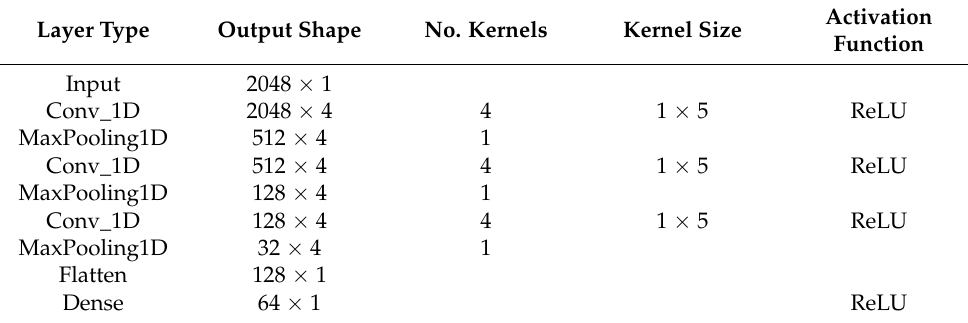
Table 3. The parameters of the proposed Siamese network with CNN.